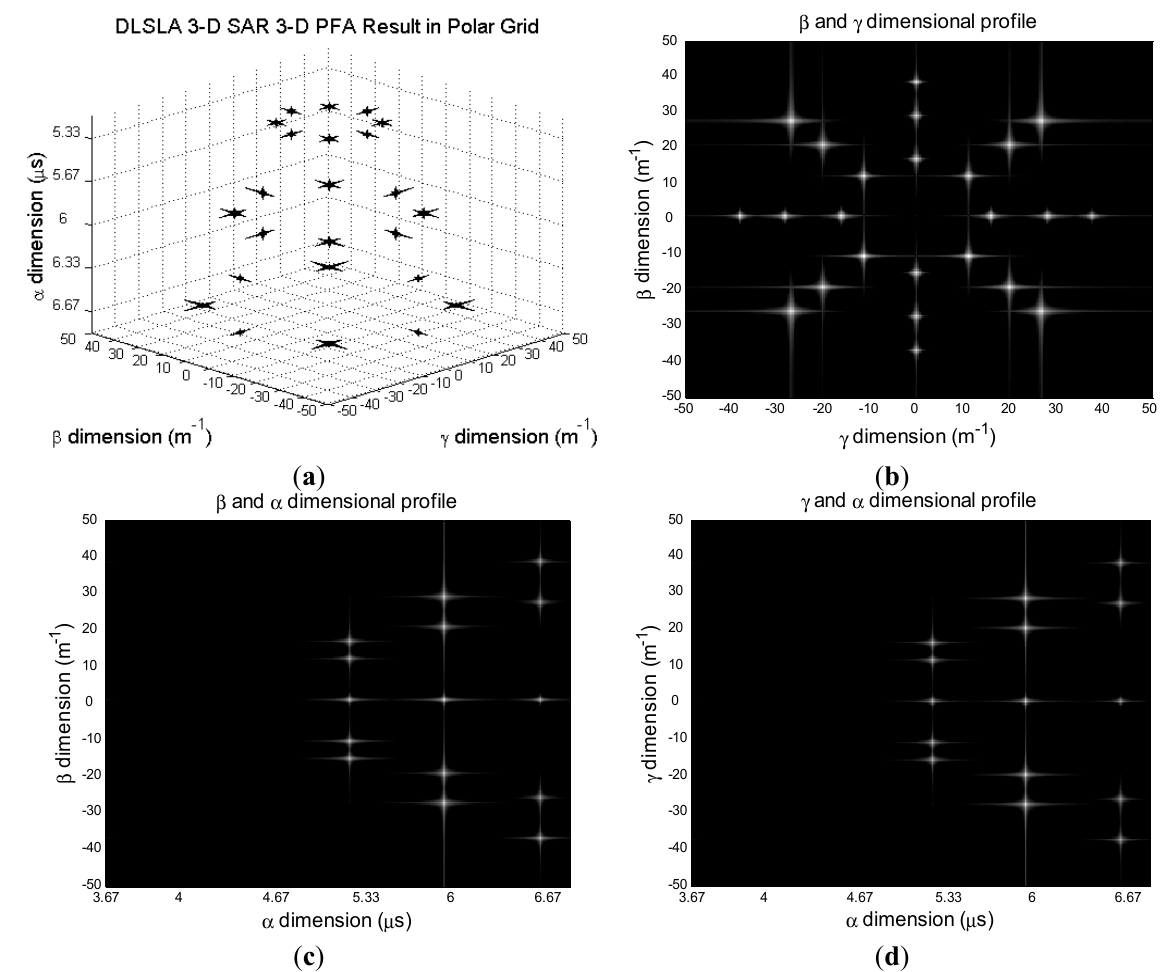
Figure 11. Imaging result in polar coordinate grid without wave front curvature error compensation: ( a ) 3-D imaging result. ( b ) Image projected onto βγ plane. ( c ) Image projected onto βα plane. ( d ) Image projected onto γα